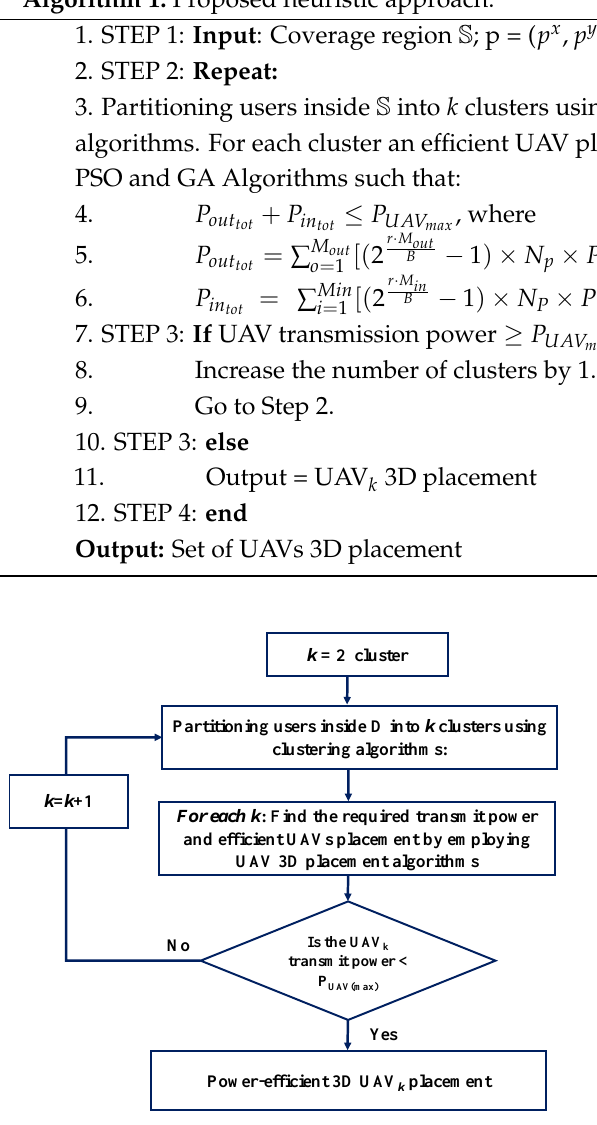
Algorithm 1: Proposed heuristic approach.